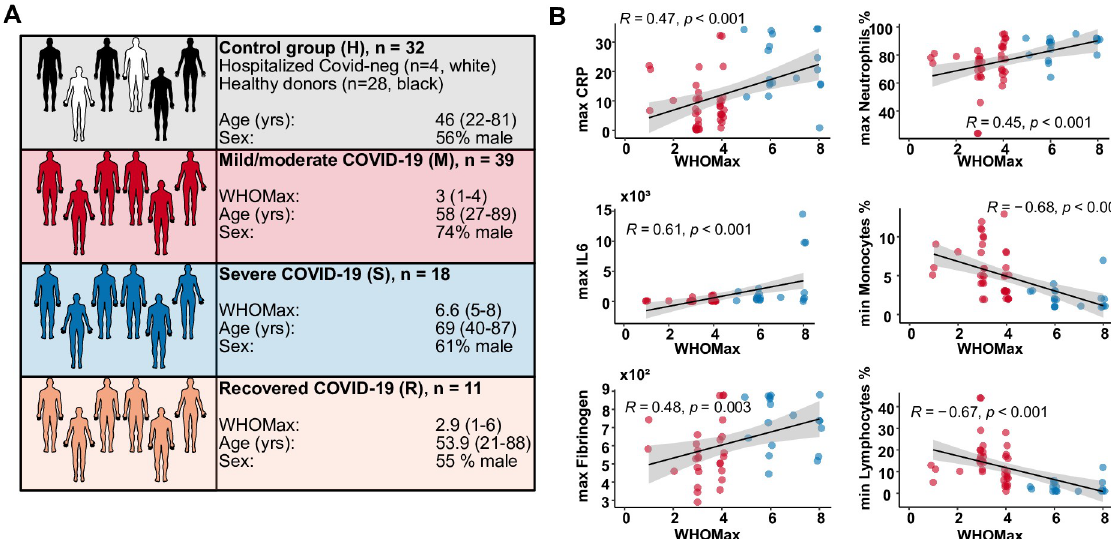
Fig 1. Characterization of the study cohorts. (A) The number, age, sex and maximal WHO ordinal scale (WHO max) reached are shown for the four different study groups. The control group (H) contained 28 healthy blood donors (black) and 4 SARS-CoV-2-negative patients (white). Patients with acute COVID-19 were grouped into mild/moderate (M, red, n = 39) and severe (S, blue, n = 18). A group of recovered patients was included for comparison (R, orange, n = 11). (B) Correlation analysis of WHO max values with routine laboratory values (minimal and maximal values reached during hospitalization). CRP, C-reactive protein. Spearman’s rank correlation coefficients, p-values and linear regression lines are shown.